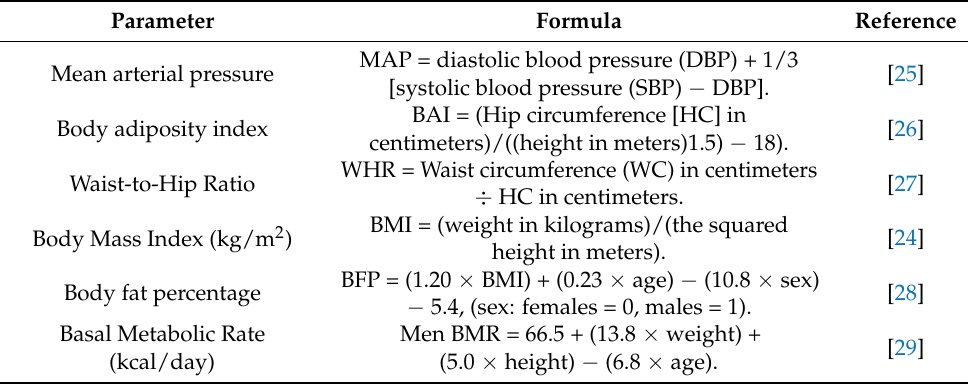
Table 1. Cardiovascular and obesity indices